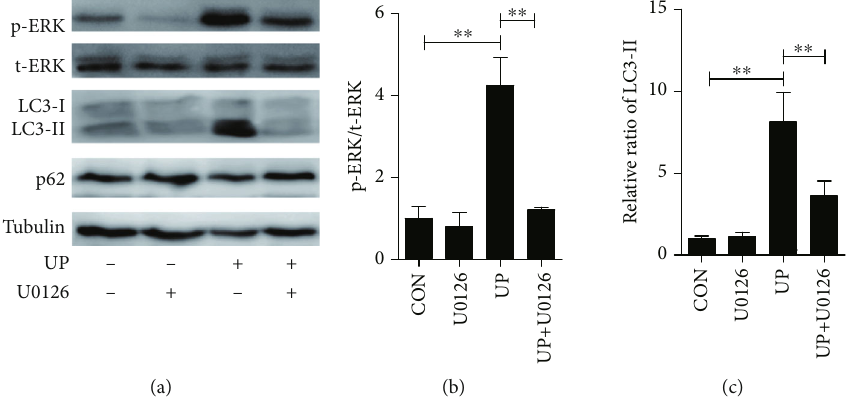
Figure 3: E ff ect of MEK inhibitor on urinary protein-induced autophagy. MEK inhibitor U0126 (10 μ M) was administered 1 h before the addition of 8 g/l urinary proteins for 8 h. Aliquots of cell lysate were subjected to Western blot analysis of p-ERK, t-ERK, LC3, and p62 levels. (b) F ð 312 Þ = 16 : 329 ; (c) F ð 3 8 Þ = 11 : 229 . ∗∗ P < 0 : 01 . CON: control; UP: urinary